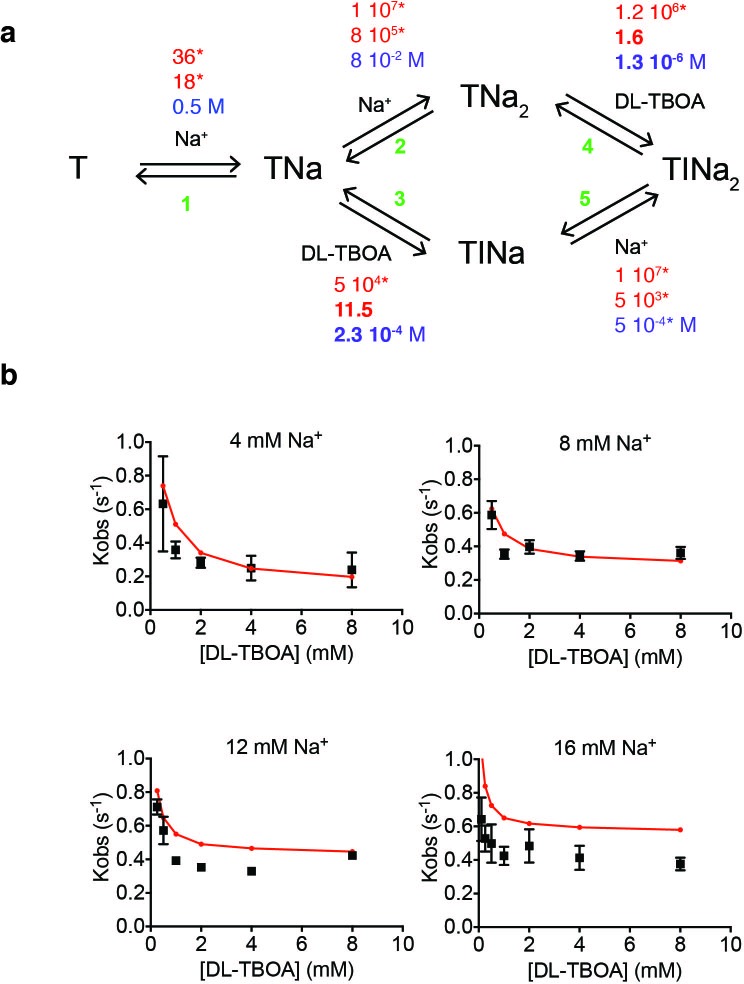
Kinetic modeling of DL-TBOA binding to P11WIFS.(a) The shown kinetic model was implemented in KinTek. Binding (red), unbinding (blue) kinetic constants and equilibrium dissociation constants (black) are in s−1 M−1, s−1 and M, respectively. All kinetic constants marked by stars were fixed to values used to fit L-asp binding data. Only the rates of DL-TBOA dissociation in reactions 3 and 4 (shown in bold) were fitted. (b) The model (red) recapitulates the experimental data (black) for DL-TBOA binding reasonably well.